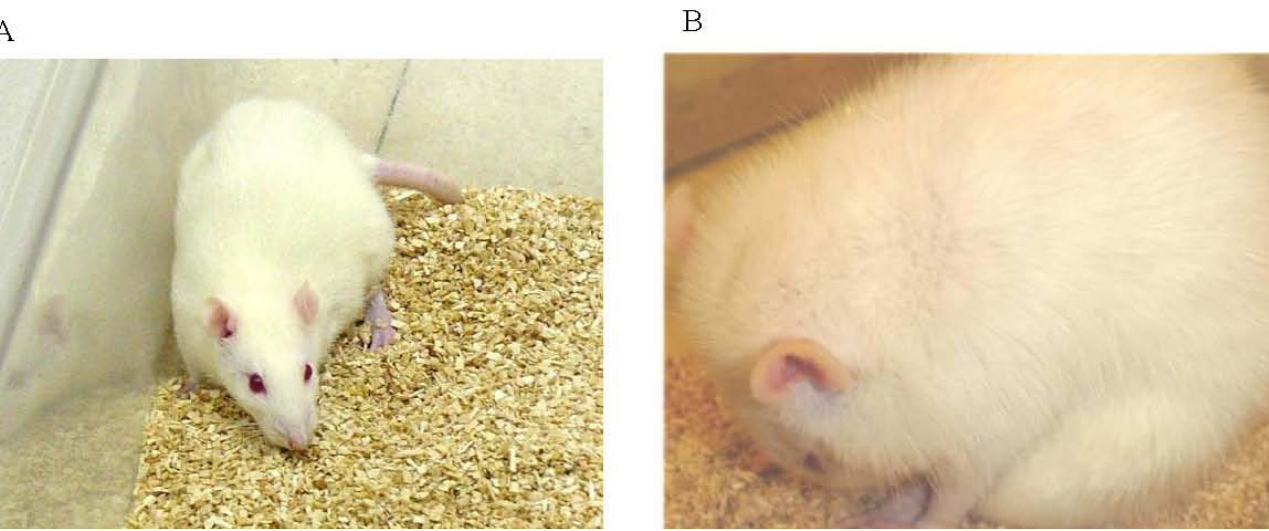
FIGURE 1 – (A) No ruffled fur (B) Ruffled